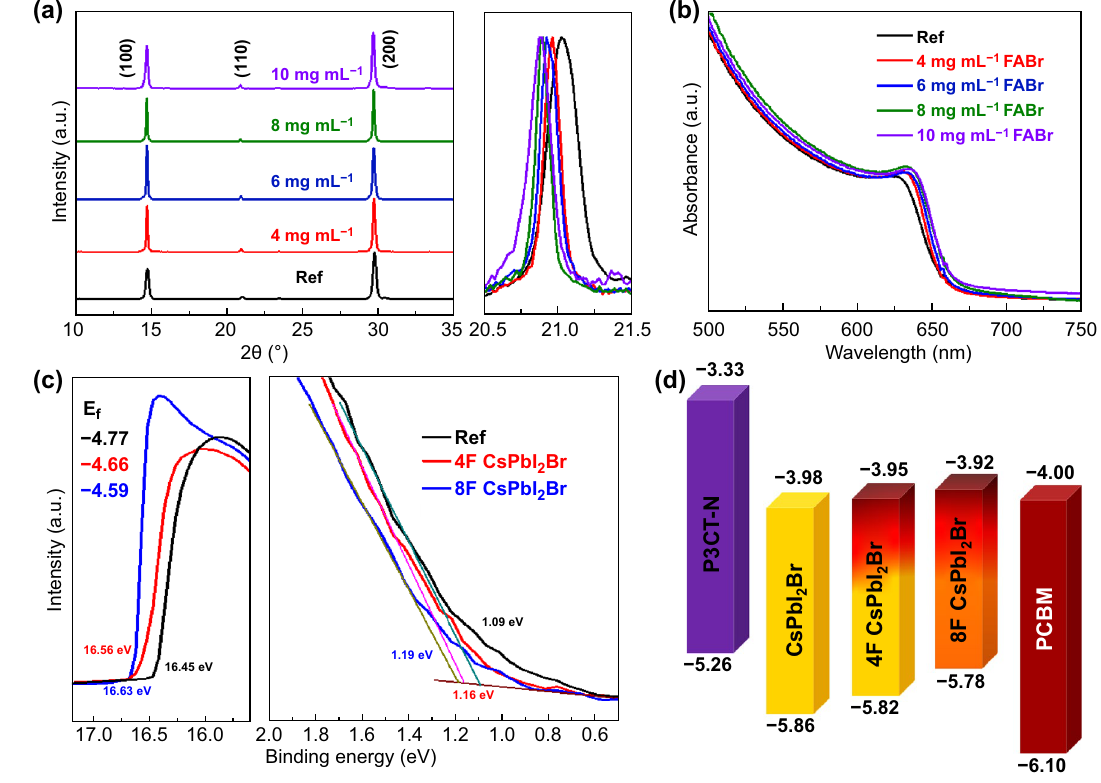
Fig. 1 a XRD patterns, b UV–Vis absorption spectra, and c UPS spectra of the CsPbI 2 Br films treated with various FABr concentrations. d Energy level diagram of treated